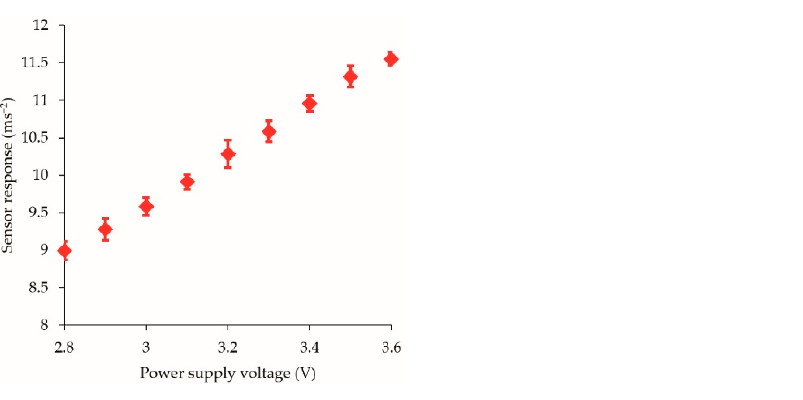
Figure A2. Graph of the relationship between the sensor response and the power supply voltage at a vibration amplitude of 10 ms − 2 and at 80 Hz.